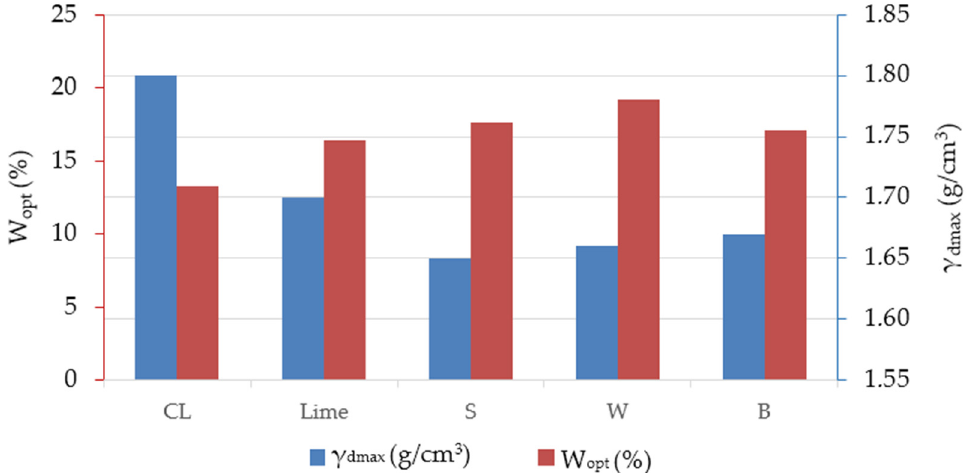
Figure 4. Compaction characteristics.